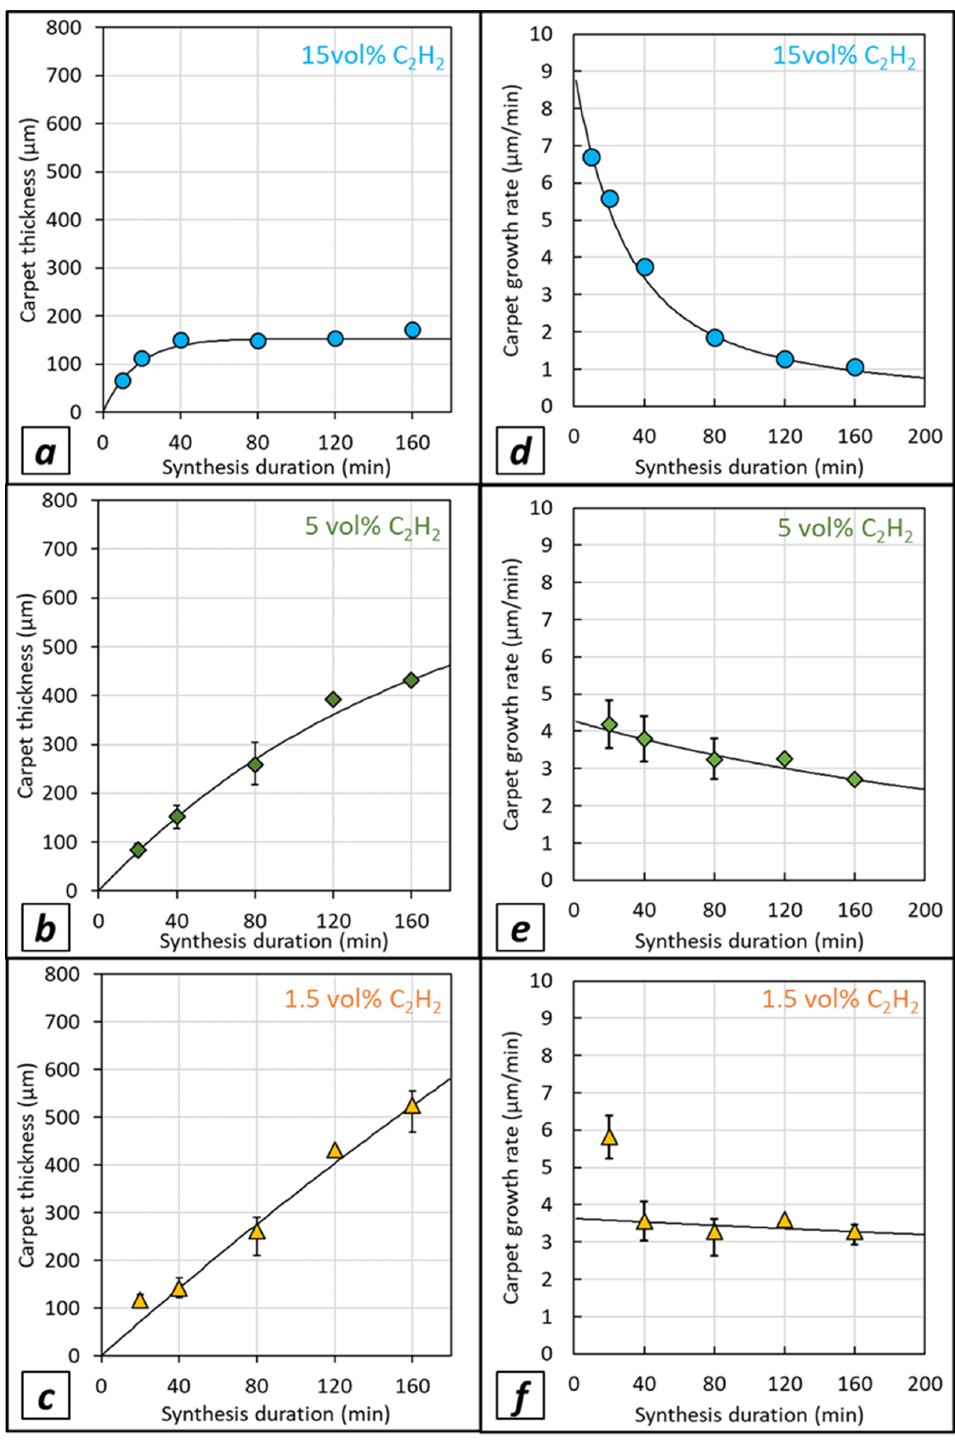
Figure 5. Carpet thickness versus synthesis duration on LG-Al substrates, for various acetylene contents ( a ) 15 vol%, ( b ) 5 vol% and ( c ) 1.5 vol%. Exponential model fittings are also plotted (plain black lines). Growth rate versus synthesis duration for various acetylene contents: ( d ) 15 vol%, ( e ) 5 vol%